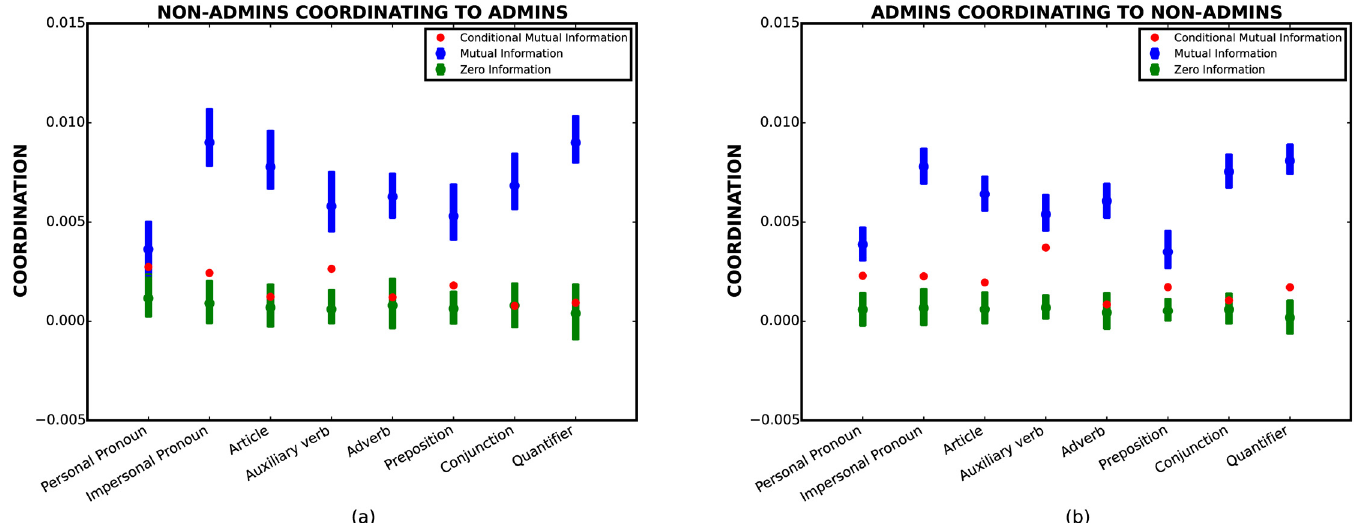
Fig 2. Coordination measures for the Wikipedia data. (a) Non-admins coordinating to Admins. (b) Admins coordinating to Non-admins. Symbols have the same interpretation as in the previous